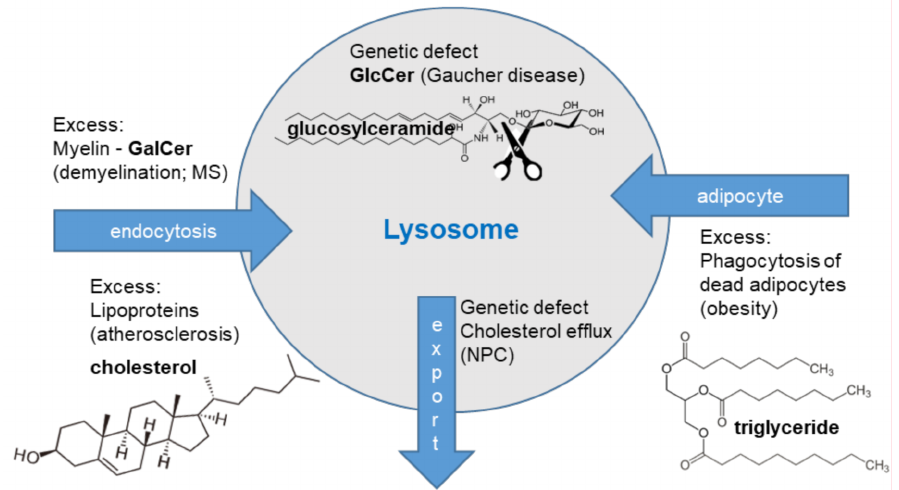
Figure 1. The lysosomal macrophage phenotypes. Gaucher disease is a genetic disease and glucosyl- ceramide (GlcCer) accumulates within lysosomes of Gaucher cells. Niemann-Pick type C (NPC) is caused by a genetic defect in cholesterol transport proteins, driving cholesterol and glycosphingolipid accumulation in macrophages. Increased endocytosis of myelin causes increased lysosomal load in multiple sclerosis (MS) macrophages. Increased uptake of lipoprotein particles drives lysosomal lipid loading in atherosclerotic plaque macrophages. Uptake of apoptotic adipocytes causes triglyceride accumulation in adipose tissue